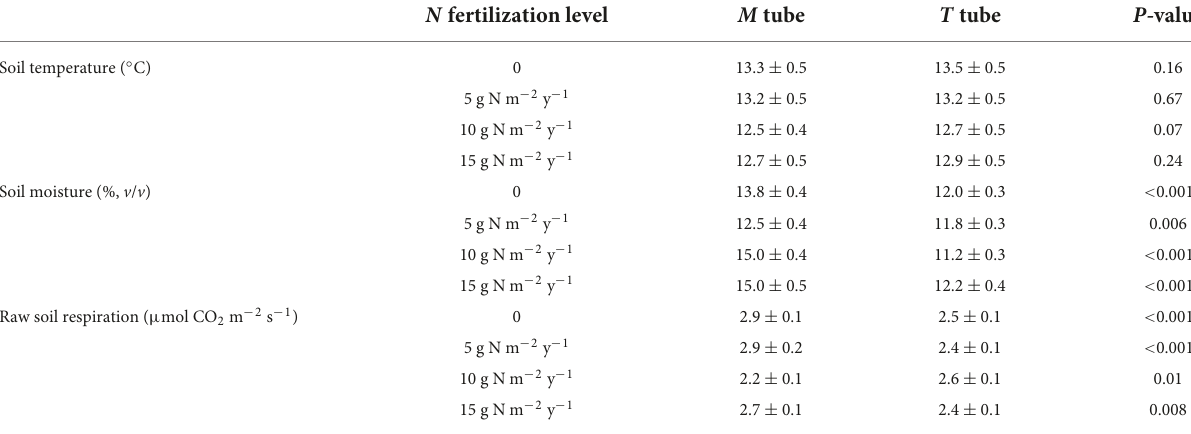
TABLE 1 Soil temperature and moisture at 5 cm depth and soil respiration of both M tubes and T tubes for each fertilization